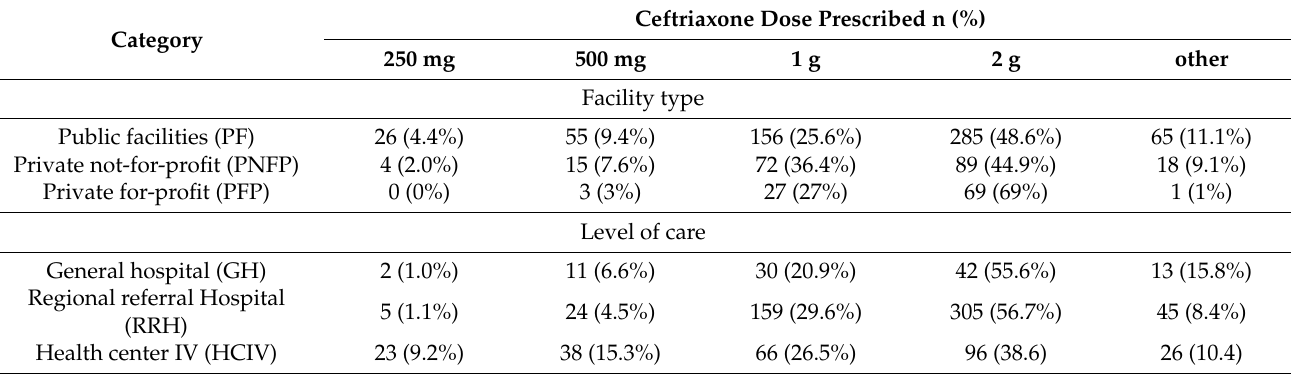
Table 4. Ceftriaxone doses prescribed by health workers in the different categories of health facilities.